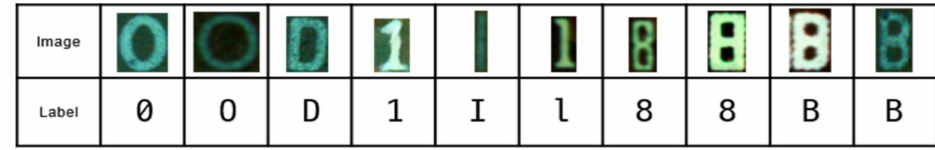
Figure 14. Examples of ambiguity between classes.